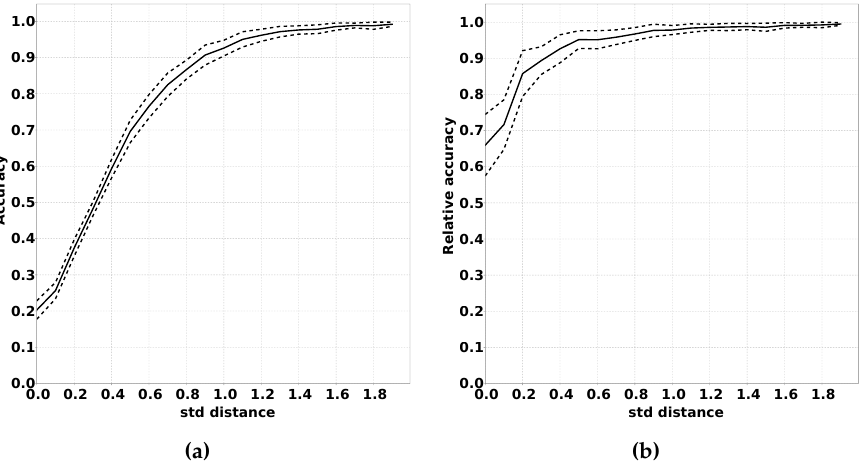
Figure 11. Influence of increasing the number of standard deviations between the mean of data distribution of the output classes. ( a ) Accuracy; ( b ) Accuracy relative to fully supervised trained